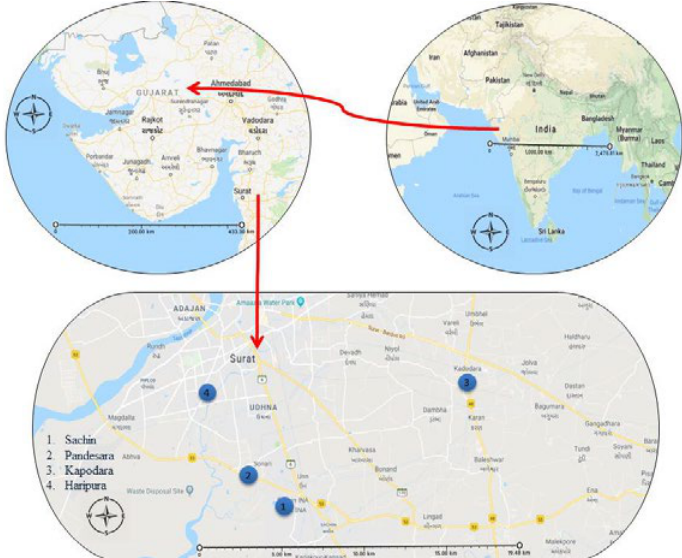
Fig. 1. Geographical location of the study area along with the sample collection Fig. 1: Geographical location of the study area along with the sample collection sites